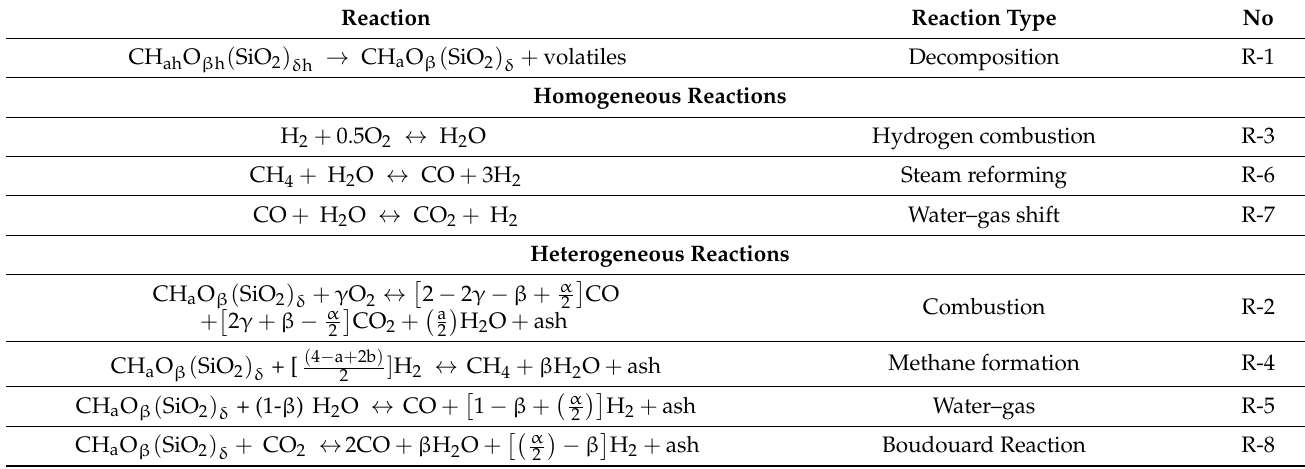
Table 3. Reactions used in simulation with Aspen